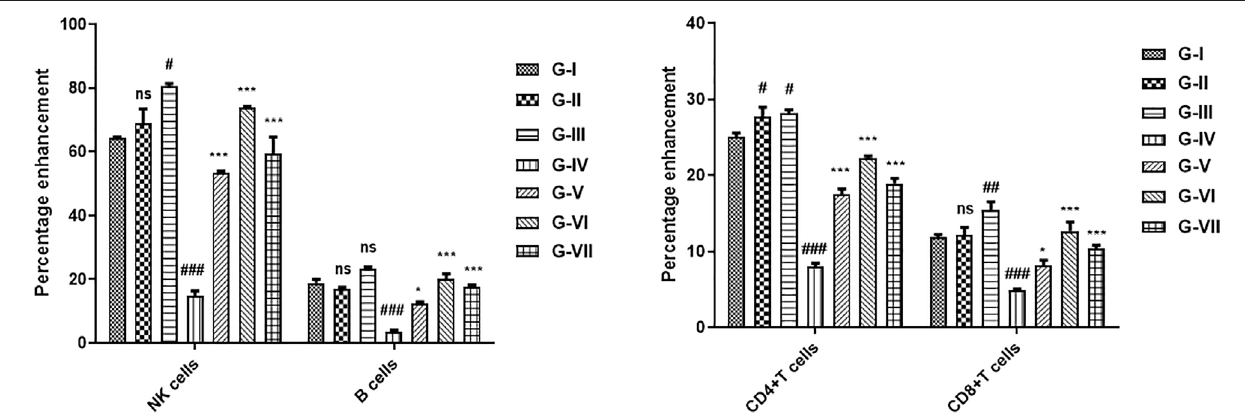
FIGURE5| Effectofthedevelopedpolyherbalcombinationoncyclophosphamide-inducedimmunosuppressedmice.DatawereobtainedfromFACSanalysis, (A) natural killer (NK) cells and B cells, and (B) CD4 and CD8 cells. The data were indicated as mean ± SEM. Results were analyzed by two-way ANOVA, and the level of signi fi cantdifferencesamongdifferentgroupswasdeterminedbyBonferroniposttestusingGraphPadPrismversion5.00software.At95%con fi denceinterval,p < 0.05 was considered as statistically signi fi cant, ns p > 0.05, *p < 0.05, **p < 0.01, ***p < 0.001; hash “ # ” denoted that data were compared to normal control, and asterisk “ * ” denoted thatdata werecompared totoxic control. G-I (Normal control), G-II (Sham lowdose),G-III (Sham high dose),G-IV (Toxiccontrol), G-V(Combination low dose), G-VI (Combination high dose), and G-VII